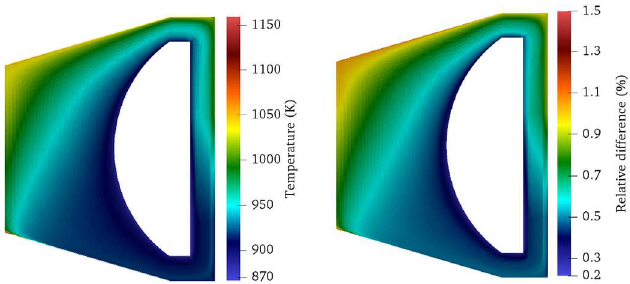
Fig. 5. The reduced order solution for the temperature together with its absolute deviation from the full order